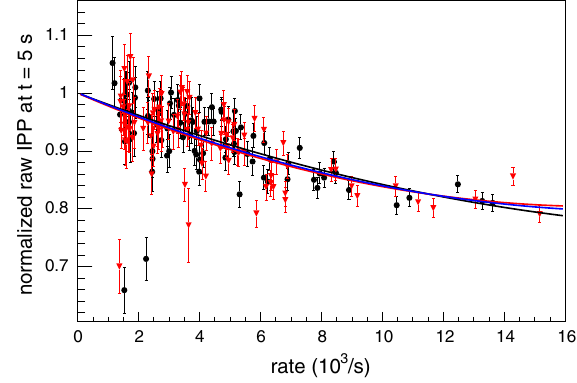
FIG. 8. The normalized value of the measured IPP in time bin 5 as a function of the EDDA detector rate. The curves are a polynomial fit to the measurements. The black curve fits the black points for spin down; the red curve fits the red points for spin up; and the blue curve fits both. The IPP values have been scaled upward by a factor for each polarization state that makes the typical low-rate bin-5 polarization equal to one. In the analysis for all time bins, the measured IPP was adjusted upward by the appropriate factor to compensate for this loss.